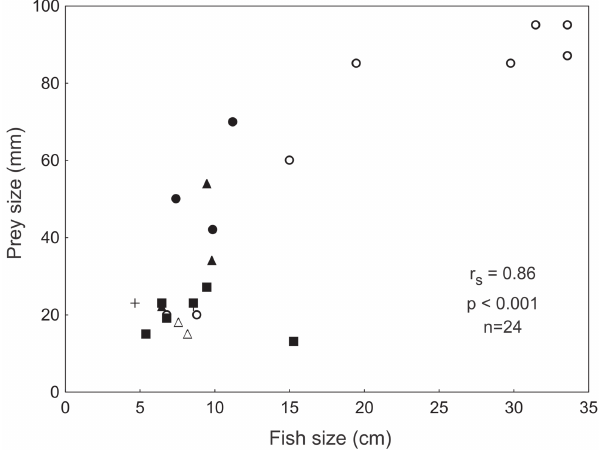
Fig. 8. Scatterplot of prey size vs. fish size for fishes found in the stomachs of three species of snappers (data pooled for all species). Main food categories identified by different symbols: White circles = Eleotridae; Black circles = Congridae; Triangles = Engraulidae; White triangles = Lutjanidae; Crosses = Centropomide; Black square =